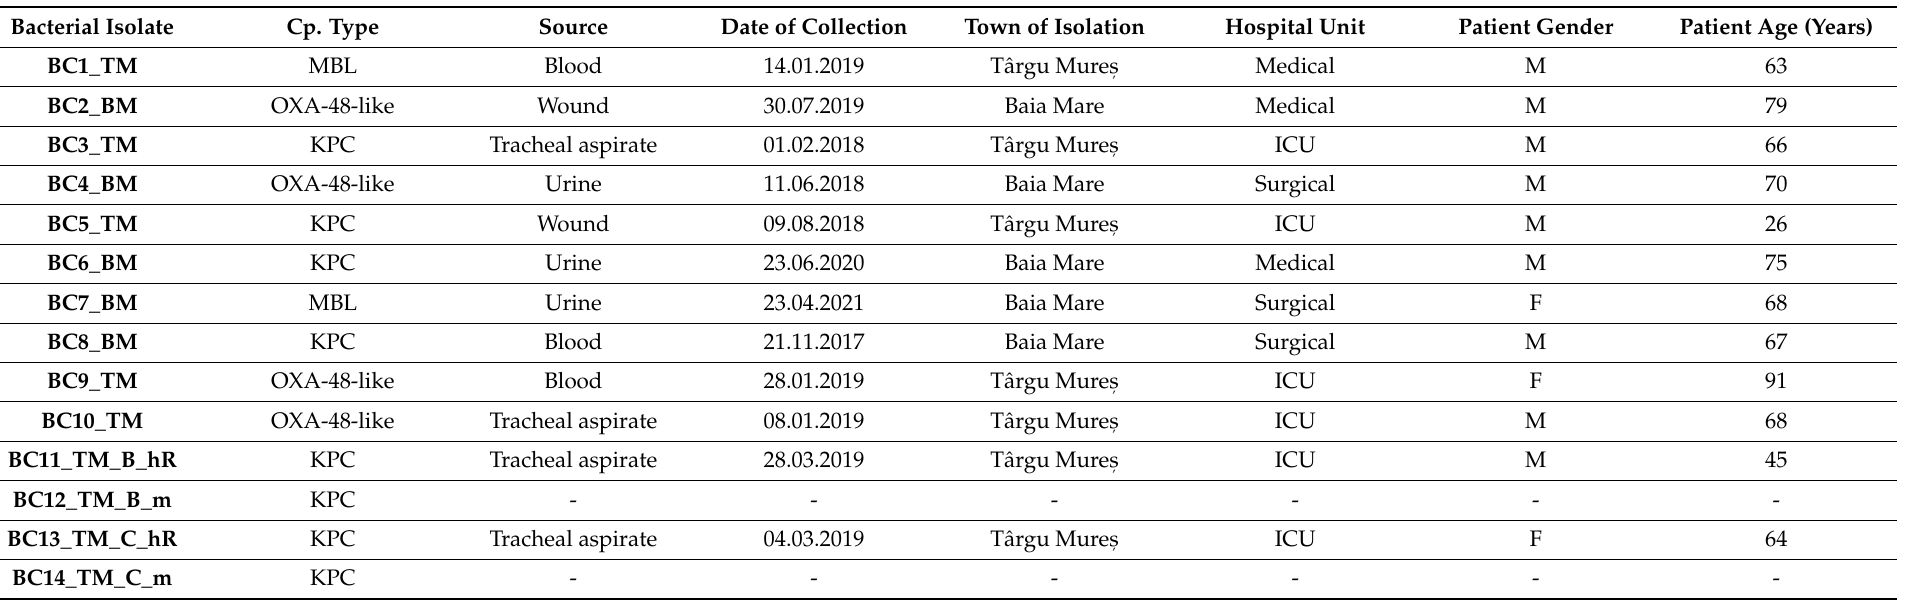
Table 8. Demographic data of patients and general details of CR and ChR K. pneumoniae CPE isolates. Bacterial